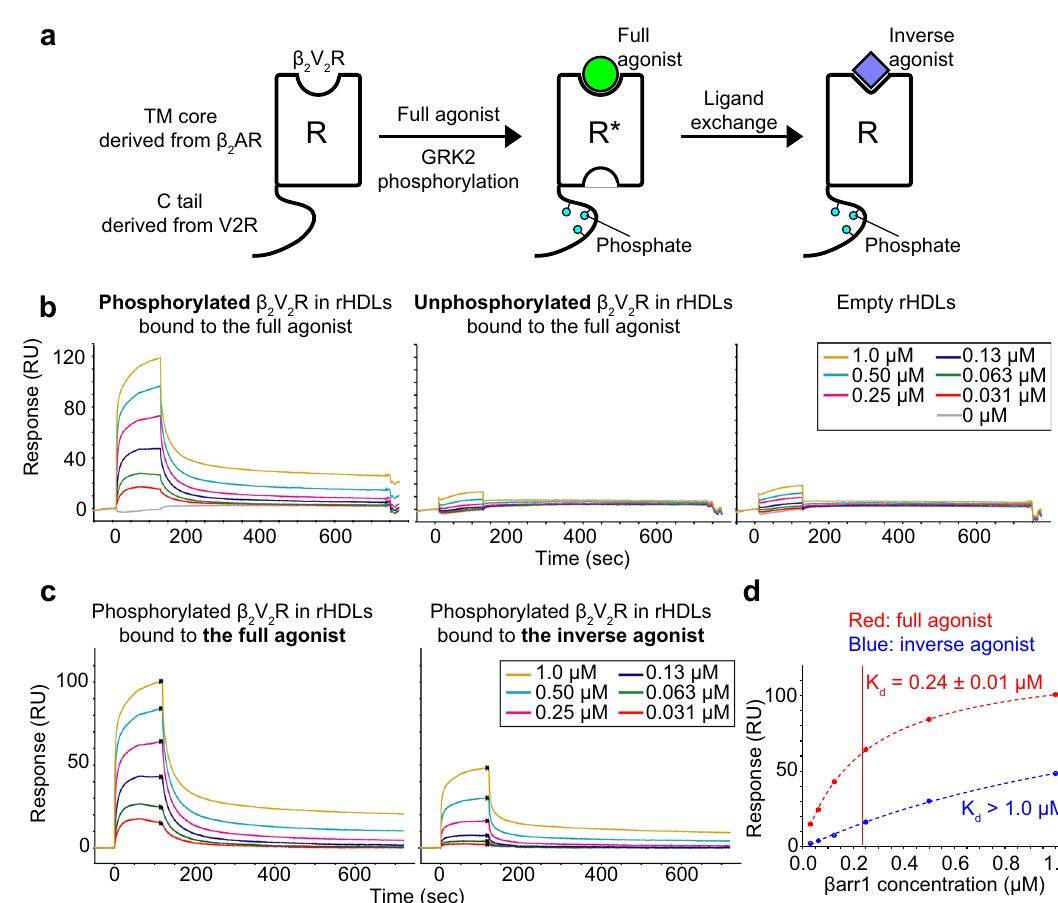
Fig. 1 SPR analyses of the interactions between β arr1 and β 2 V 2 R in rHDLs. a Schematic representation of the various forms of β 2 V 2 R, composed of the TM core from β 2 AR and the C tail from V2R, used in this study. Puri fi ed β 2 V 2 Rs in rHDLs bound to the full agonist are phosphorylated by GRK2. Afterwards, the full agonist was replaced with the inverse agonist. b Overlay plots of sensorgrams obtained for the interactions of 0, 0.031, 0.063, 0.13, 0.25, 0.50, and 1.0 μ M β arr1 with unphosphorylated β 2 V 2 R in rHDLs (left), phosphorylated β 2 V 2 R in rHDLs (middle), and empty rHDLs (right). c Overlay plots of sensorgrams obtained for the interactions of 0.031, 0.063, 0.13, 0.25, 0.50, and 1.0 μ M β arr1 with phosphorylated β 2 V 2 R in rHDLs bound to the full agonist (left) and those bound to the inverse agonist (right). To accurately extract the ligand effects, sensorgrams from the reference fl ow cell immobilized with empty rHDLs were subtracted from those of the active fl ow cells immobilized with phosphorylated β 2 V 2 R in rHDLs, and then the sensorgrams from buffer blank injections were subtracted from the reference-subtracted sensorgrams to yield the double-referenced sensorgrams. d Plots based on steady-state SPR methods between β arr1 and phosphorylated β 2 V 2 R in rHDLs bound to the full agonist (red) and the inverse agonist (blue). Each point is the average of 50 data points around the steady state in the sensorgram, and the error bars are their standard deviations. The K d values were determined by fi tting the steady-state response curves, assuming a 1:1 interaction